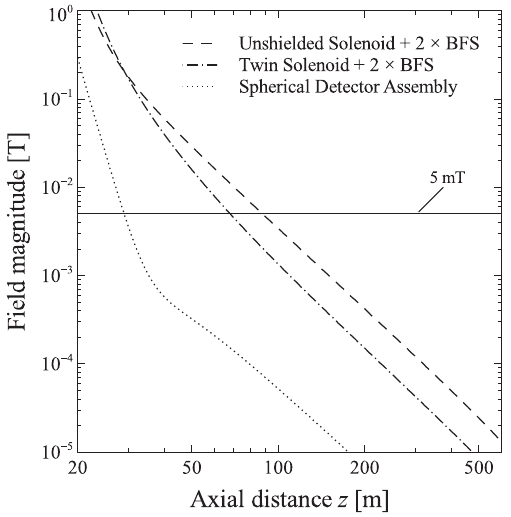
FIG. 14. Magnetic field magnitude as a function of axial distance to the interaction